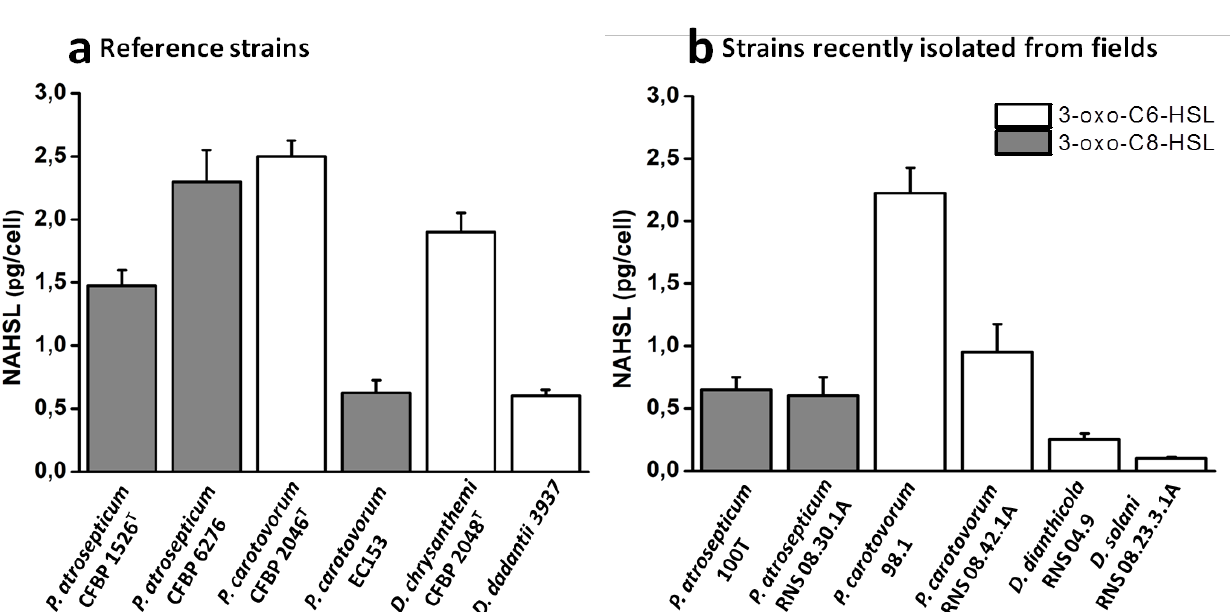
Figure 2. Concentrations of the main N -acyl homoserine lactones produced by Pectobacterium and Dickeya